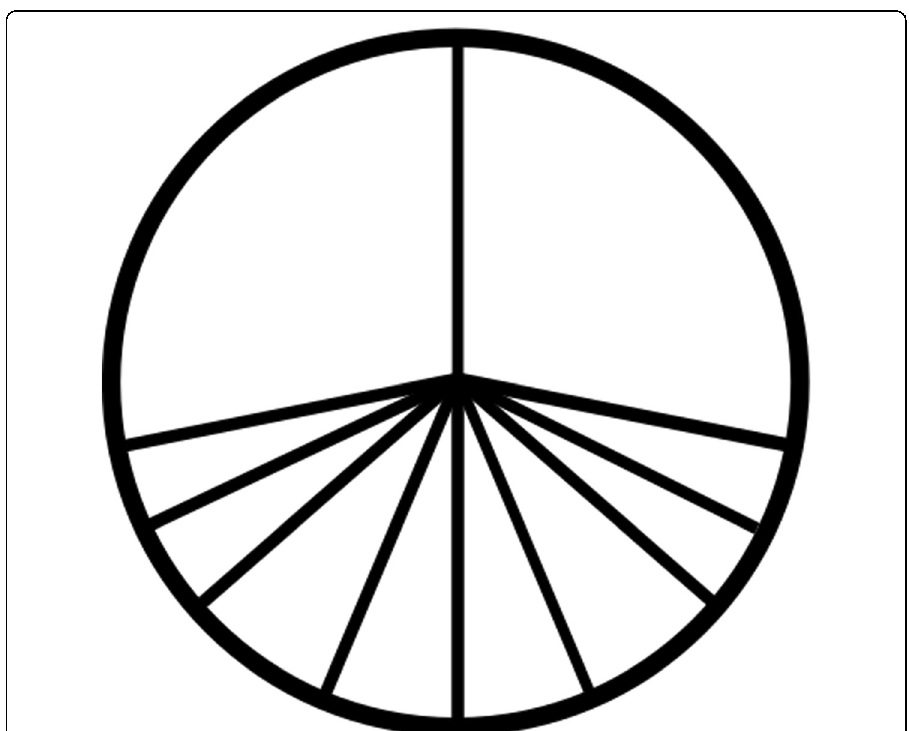
Fig. 11 Legend: The vertical line illustrates the access to learners from back-end, the diagonal lines illustrate the centralization of learners in this